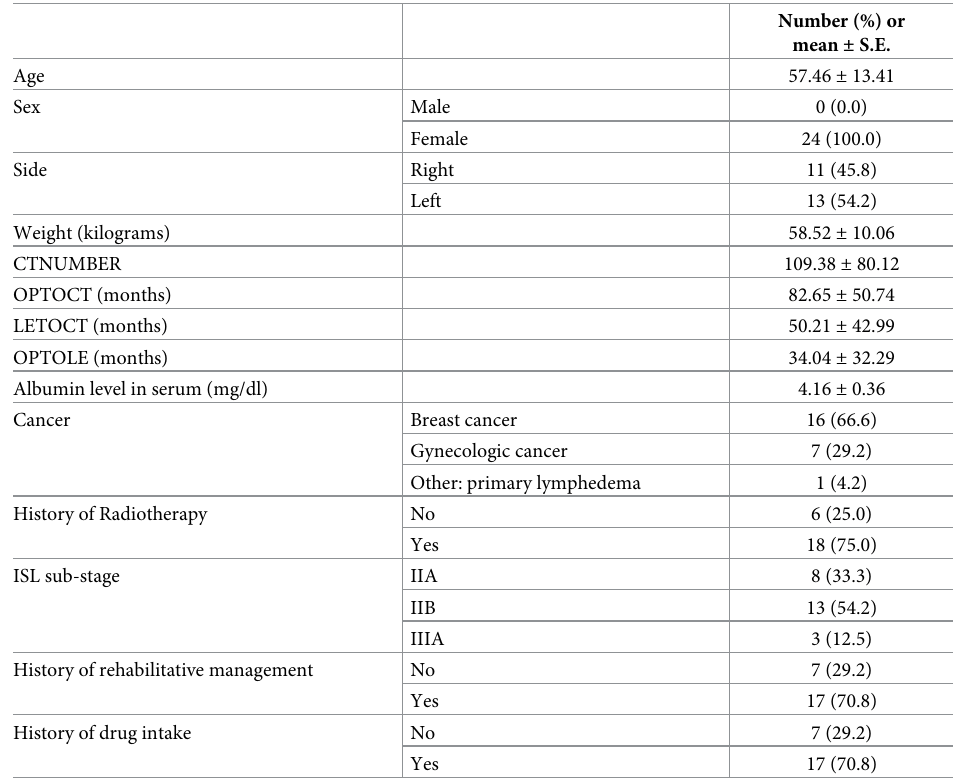
Table 1. Demographic